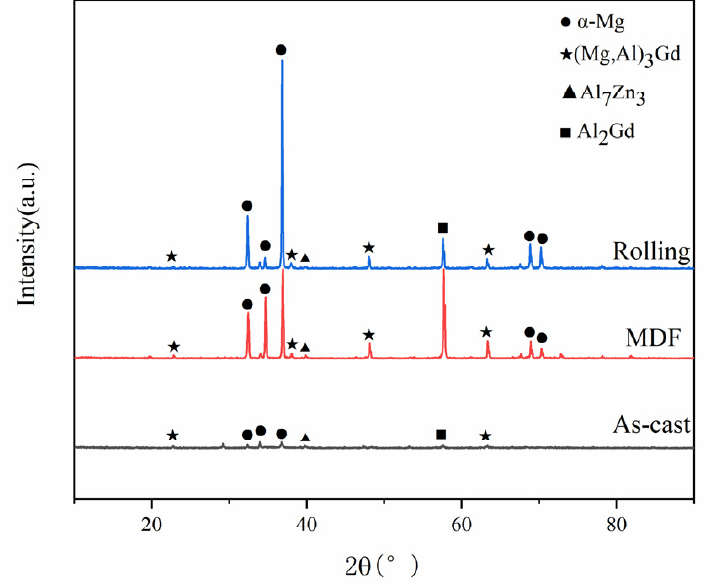
Figure 2. X-ray diffraction patterns of GAZ 211 alloy under different states. The relationship between microstructures and strength properties (load-bearing ca- pacity) at room temperature is analyzed. As shown in Figures 1 and 3, as comparison with the grain size of 53 ± 4.1 µ m in the homogenized state and the UTS and YS of 146 ± 4.1 and 88 ± 3.4 MPa, respectively, in the as-cast state, the third pass of the MDF microstruc- ture with a grain size of 26 ± 2.9 µ m corresponds to the UTS and YS of 236 ± 8.3 and 104 ± 3.5 MPa, respectively. This indicates that the microstructural refinement leads to the enhancement of the strength property. After MDF plus HR, the microstructure with a grain size of 22 ± 2.5 µ m corresponds to the UTS and YS of 260 ± 9.0 and 171 ± 6.4 MPa, respectively. Because of the MDF plus HR processing, microstructural refinement